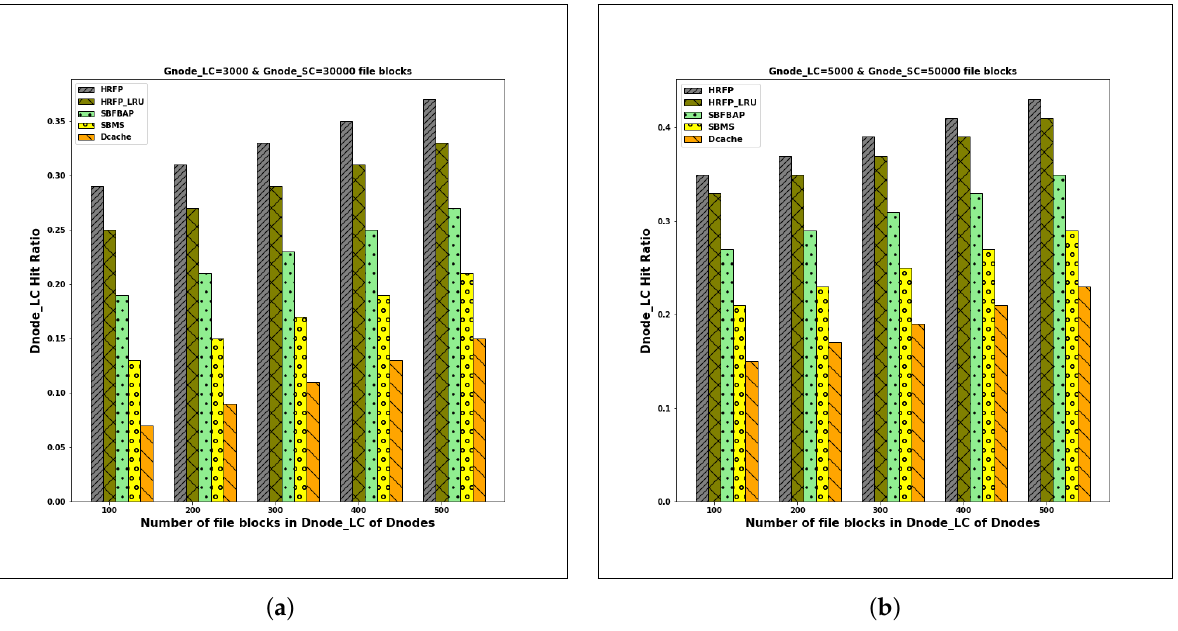
Figure 4. Figures ( a , b ) shows Hratio of Dnode_LC in Dnodes when the size of Gnode_LC is set to 3000, 5000 file blocks and size of Gnode_Sc is 30,000, 50,000 file blocks respectively. In Figure 5, the trend in the Hratio of SSD caches in Dnodes is depicted. The size of Dnode_SC is varied from 1000 to 5000 file blocks and the Dnode_LC size in Dnodes is varied from 100 to 500 file blocks. The sizes of Gnode_LC and Gnode_SC are fixed to 3000, 5000 and 30,000, 50,000 file blocks,